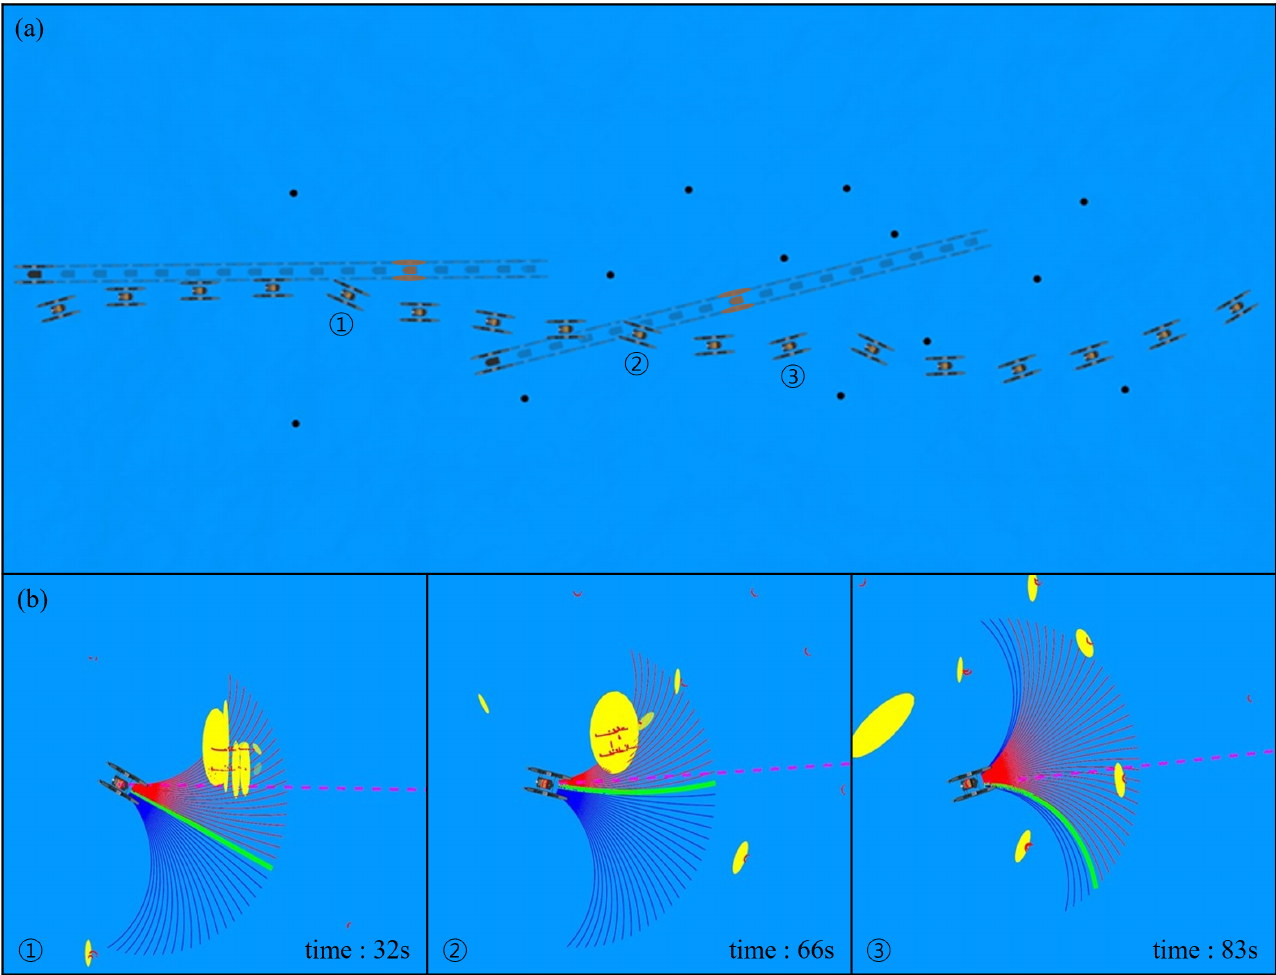
Figure 16. Results of ship trajectory and GMM mapping in the scenario with fixed and mobile obsta- cles. ( a ) Trajectory of the USV expressed in Gazebo; ( b ) Virtual information around the USV expressed in